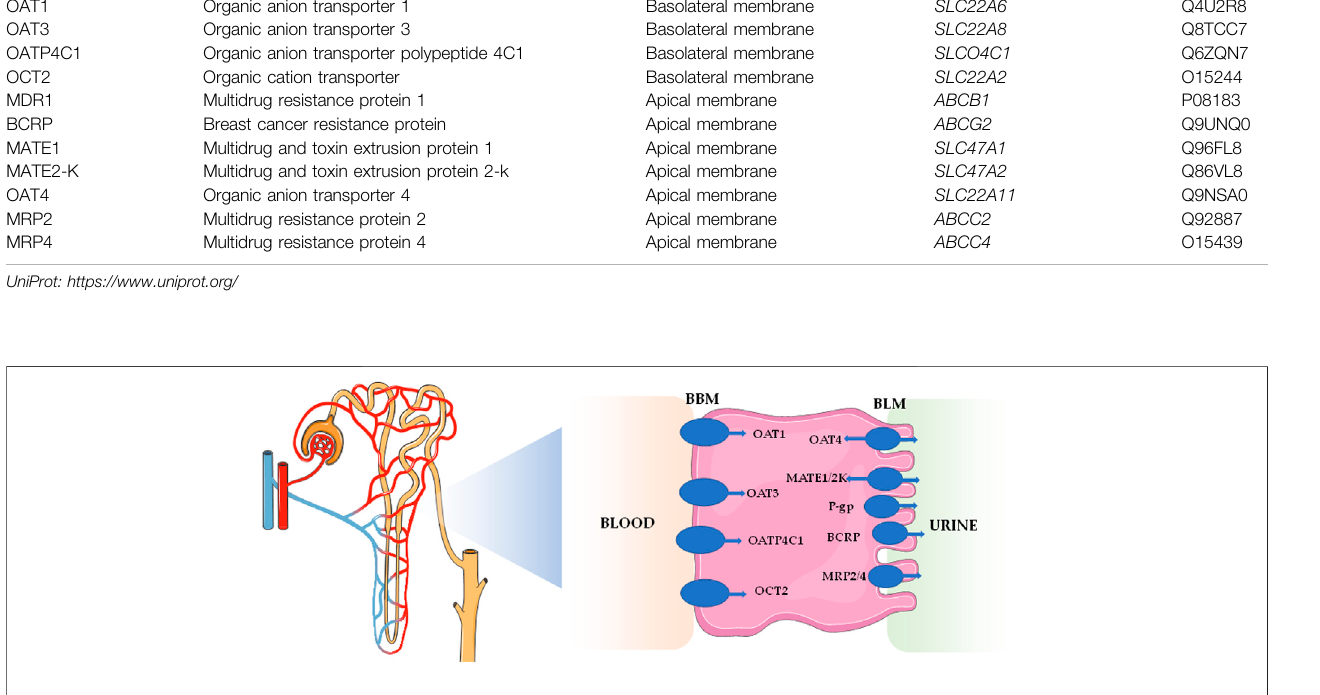
FIGURE 1 | Distribution of the major transporters located in